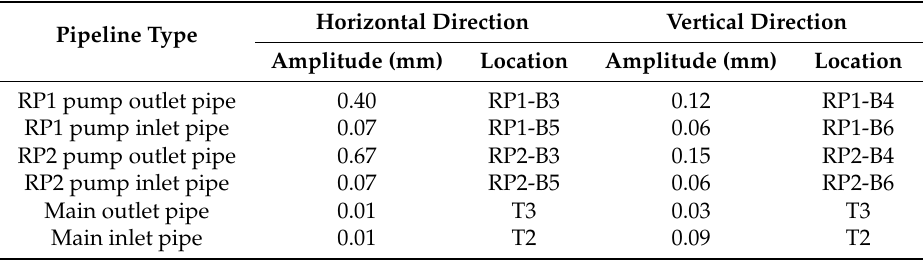
Table 8. Summary of the maximum amplitude and location.